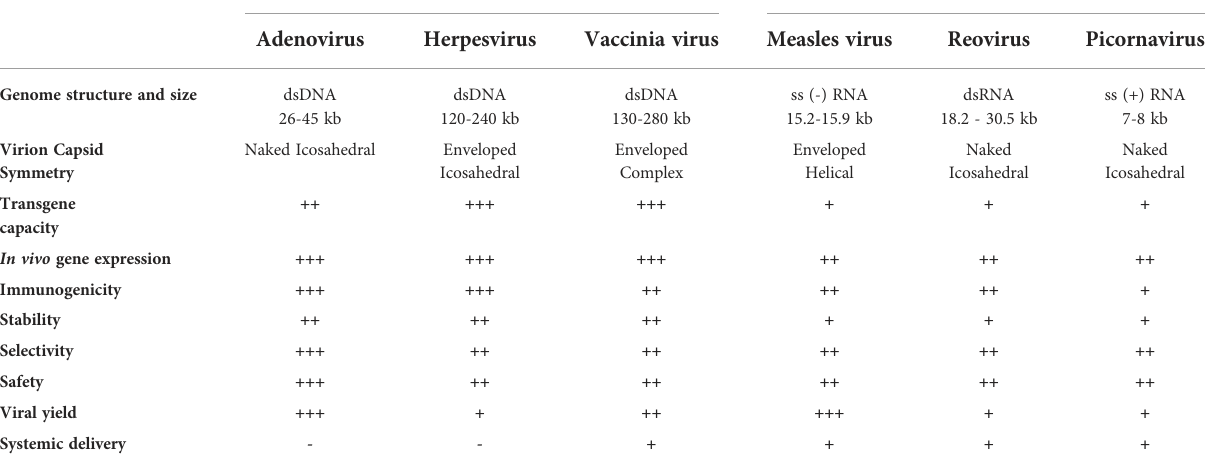
TABLE 4 Characteristics of oncolytic